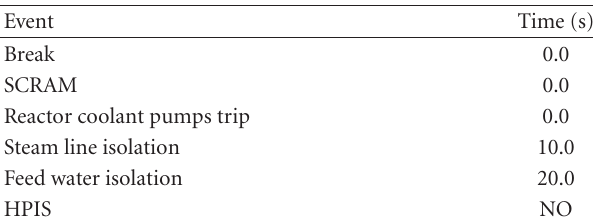
Table 2: Time sequence of imposed events.